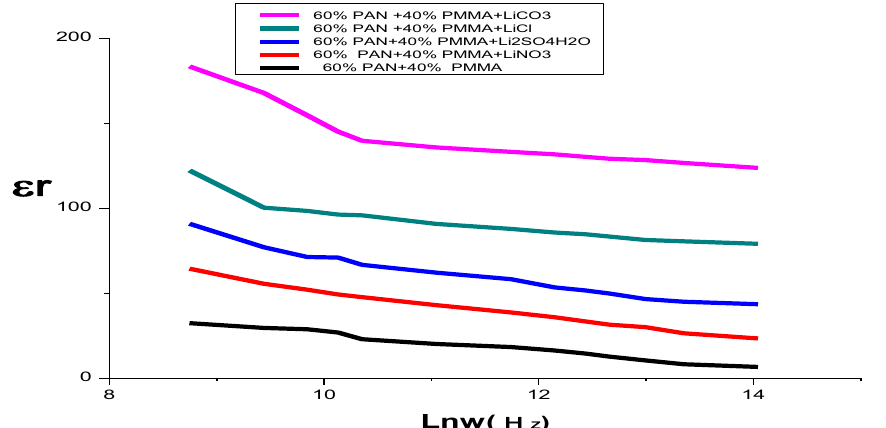
Figure 2e: The real dielectric constant as function of ln (ω) of undoped (62%PAN +40%PMMA) and doped with 20% (LiNO